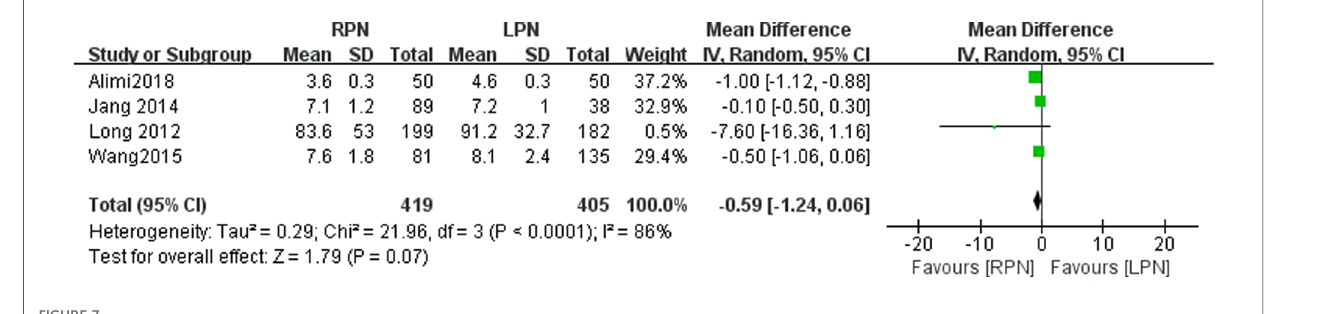
signi fi cant difference was found in the positive surgical margin between the RPN and LPN groups ( n = 1132; 573 patients in the